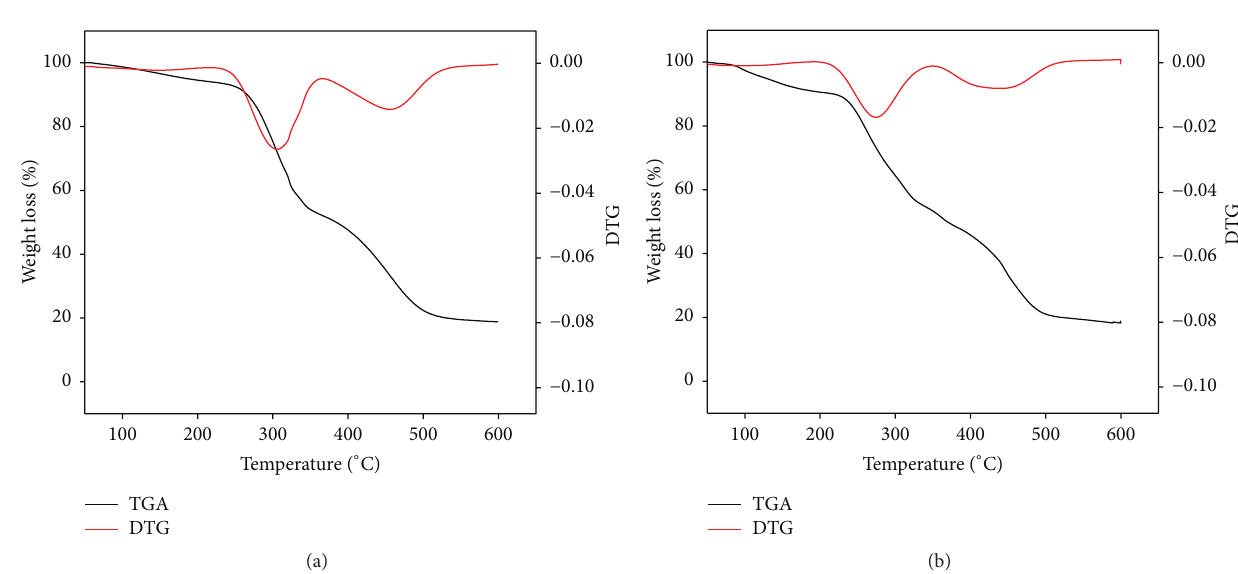
Figure 12: Thermal degradation curves: (a) [MG49-25.0 wt.% LiClO 4 ]:[8.0 wt.% HNO 3 -THF/TiO 2 -SiO 2 ] and (b) [MG49-25.0 wt.% LiClO 4 ]:[8.0 wt.% ClHNO 2 -THF/TiO 2 -SiO 2 ] polymer